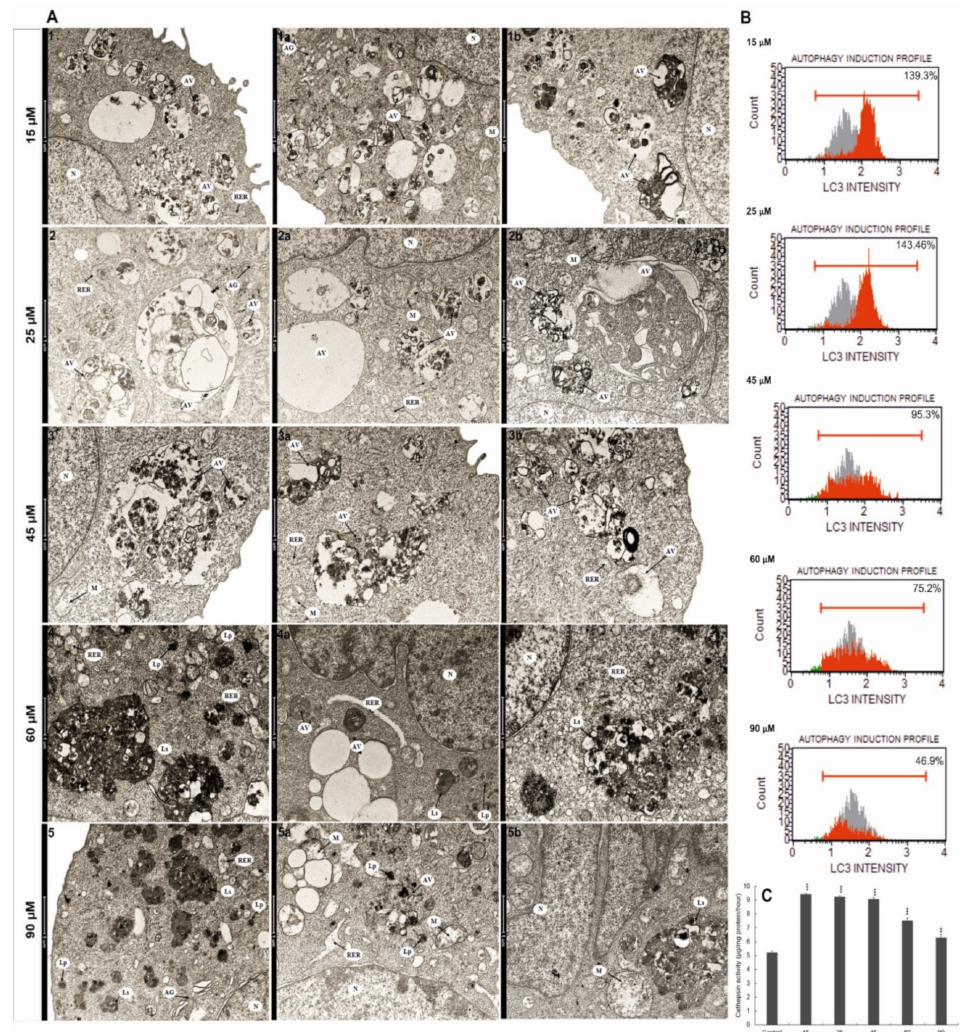
Figure 6. The intensification of degradation processes in HeLa cells with azelastine hydrochloride. ( A ) Ultrastructural changes; ( 1 – 1b ) in the cytoplasm of cells very numerous autophagic vacuoles filled with material at various stages of degradation can be seen, and an extensive Golgi apparatus and dilated channels of the rough endoplasmic reticulum; ( 2 – 2b ) clear changes in cells indicating a progressive degradation process, i.e., multiple vacuoles at different stages of digestion; ( 3 – 3b ), the image shows vacuoles differentiated in terms of shape, covering large areas of the cytosol, indicating intensive degradation; ( 4 – 5b ) dominant changes in the form of numerous primary and secondary lysosomes and changes at the level of the cell nucleus (local chromatin condensation, enlarged nuclear envelope and fragmentation). The changes obtained in the concentrations of 60 µ M and 90 µ M of azelastine indicate a progressive degradation as well as the initiation of cell death by apoptosis. ( B ) Histograms of cells indicating azelastine-induced autophagy as manifested by an increase in fluorochrome fluorescence intensity (red area) indicating LC3 protein activation. In the concentration range of 45–90 µ M, the fluorescence intensity decreased, which argued for a switch of autophagy to apoptosis. Cells were stained with anti-LC3/Alexa Fluor ® 555 conjugated antibody and the fluorescence intensity was measured cytometrically. ( C ) Changes in cathepsin D and L activities (mean ± SE) in the lysosomal fraction of HeLa cells after 48 h of exposure to different concentrations of azelastine. Results are the average of three independent experiments. Differences were statistically confirmed at: * p < 0.05, ** p < 0.01, *** p <